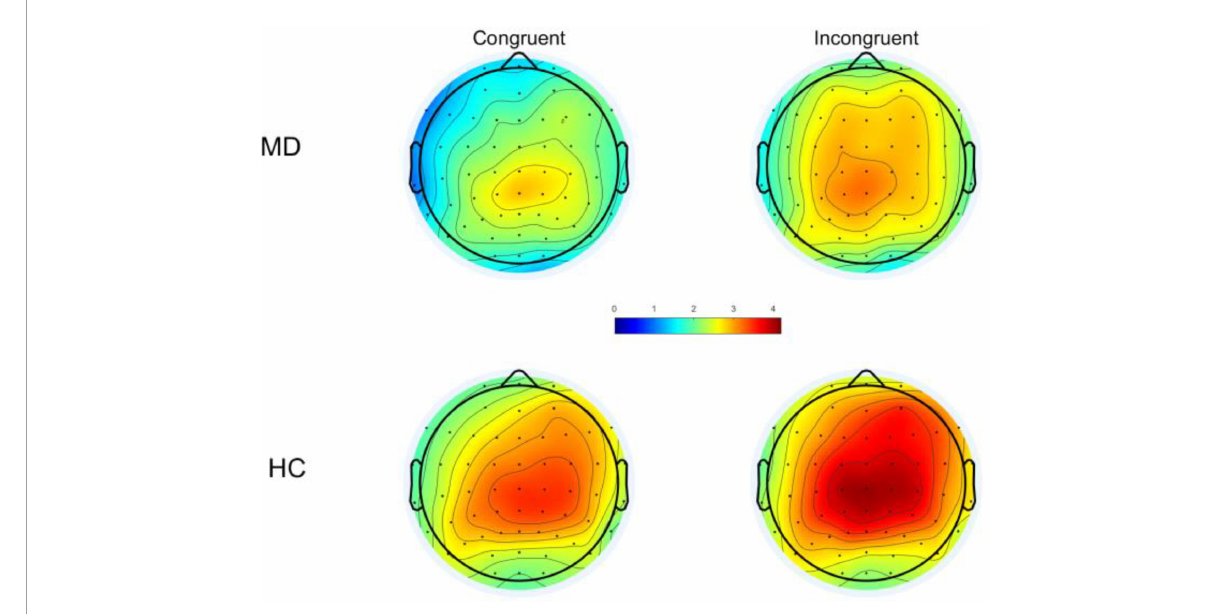
FIGURE2 Following stimulus onset, topographical distribution of P300 within a time window of 200–500 ms under congruent condition and 250–550 ms for incongruent condition. MD, major depression; HC, healthy